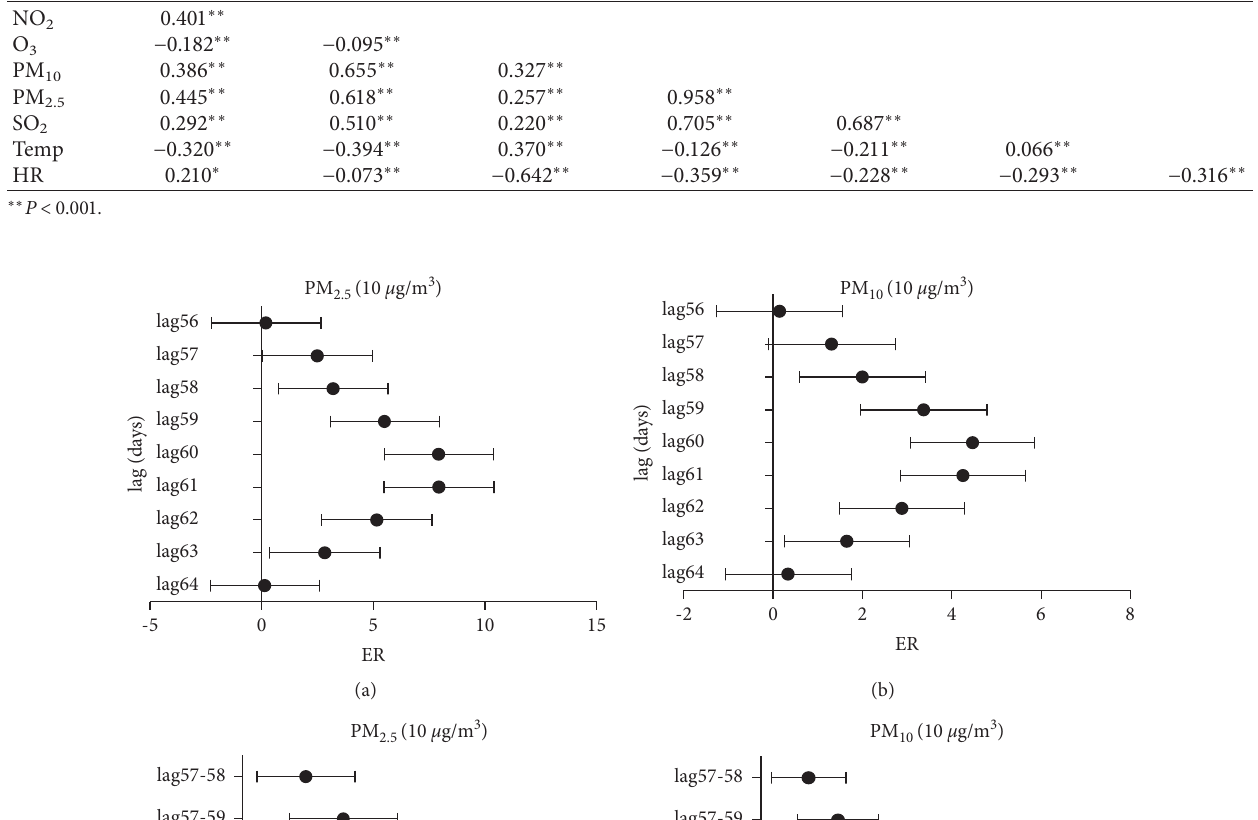
Table 3: Spearman’s correlation between air pollutants and meteorological factors in Ganzhou, China, during 2015–2020. CO NO 2 O 3 PM 10 PM 2.5